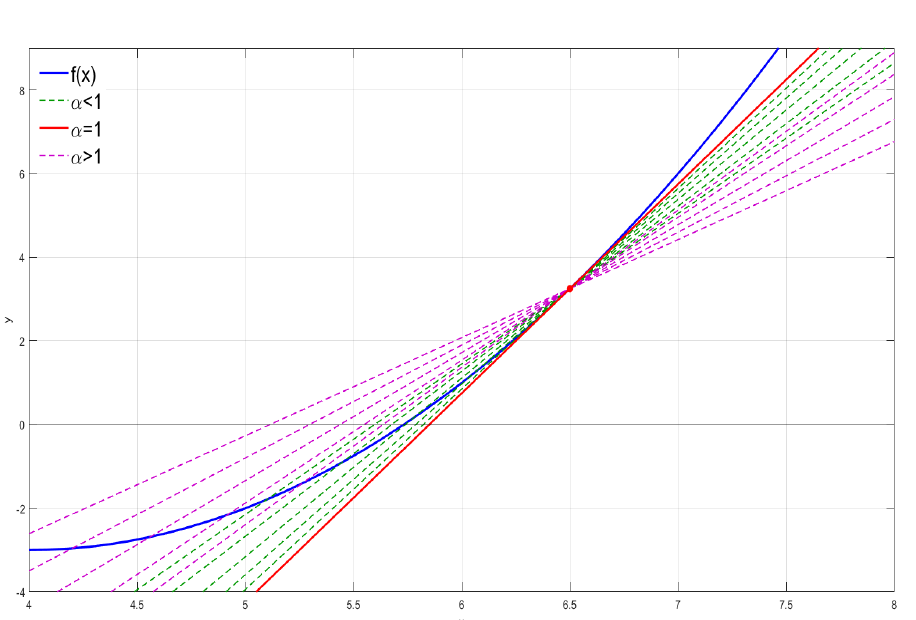
Figure 1. Illustration of some lines generated by the fractional Newton–Raphson method for the same initial condition x 0 but with different orders α of the fractional operator implemented [16]. The fractional Newton–Raphson method usually generates lines that are not tangent to the function f whose zeros are sought, unlike the classical Newton–Raphson